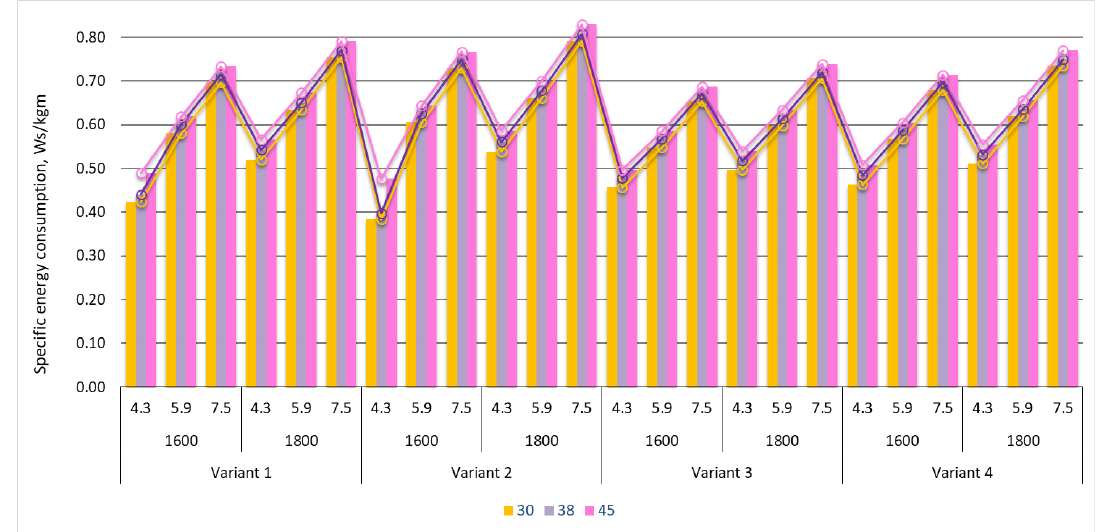
Figure 6. Bar chart of the conveyor’s specific energy consumption in trough angle series for conveyors of different design parameters working in four different variants of transported material distribution.